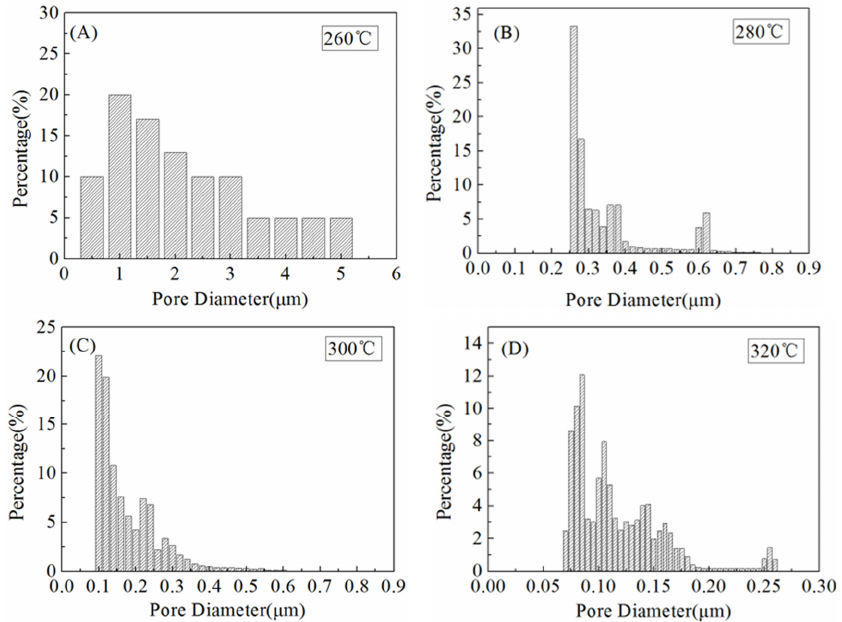
Figure 8. Pore size distribution of the ultrafine fibrous FEP porous membranes at different sintering temperature (FEP/PVA mass ratio: 1:6). ( A ) 260 °C; ( B ) 280 °C; ( C ) 300 °C; ( D ) 320 °C